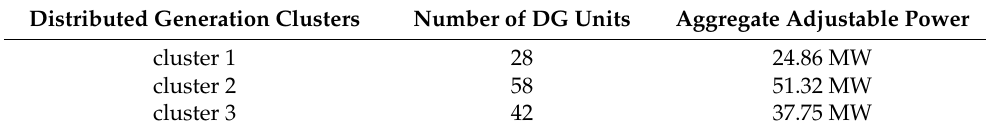
Table 2. Settings of distributed generation clusters.